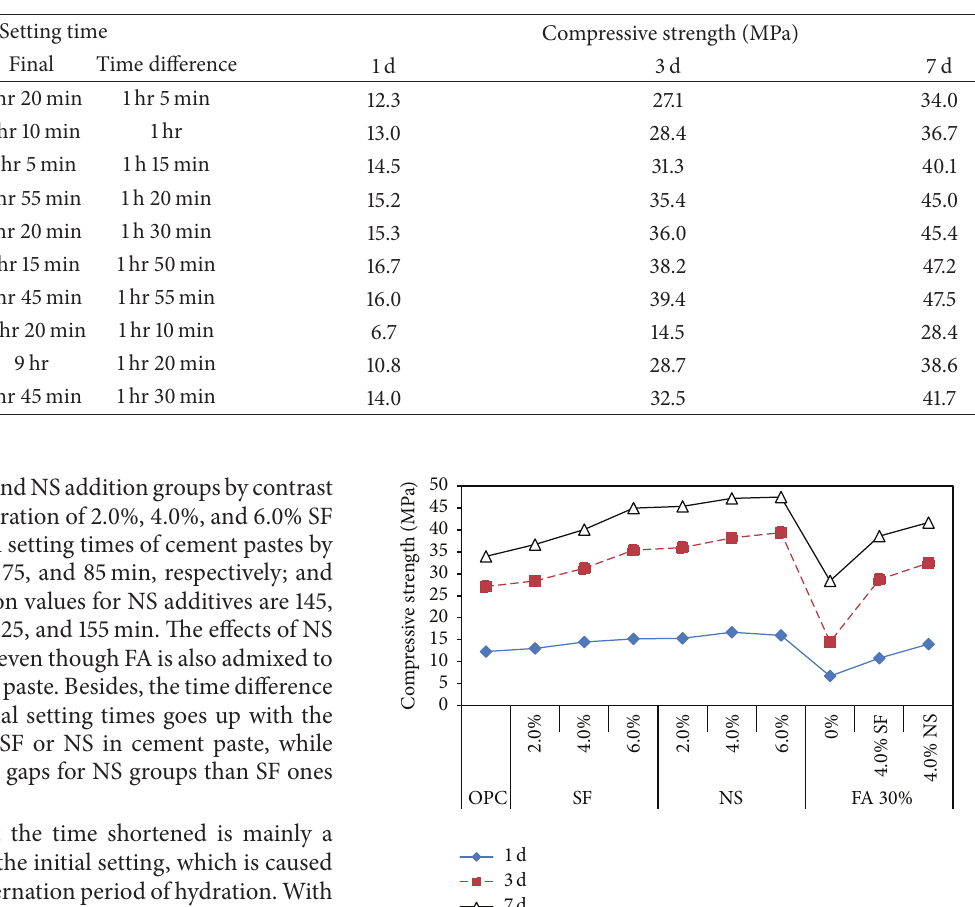
Table 3: Setting time and early-age compressive strength of cement pastes.